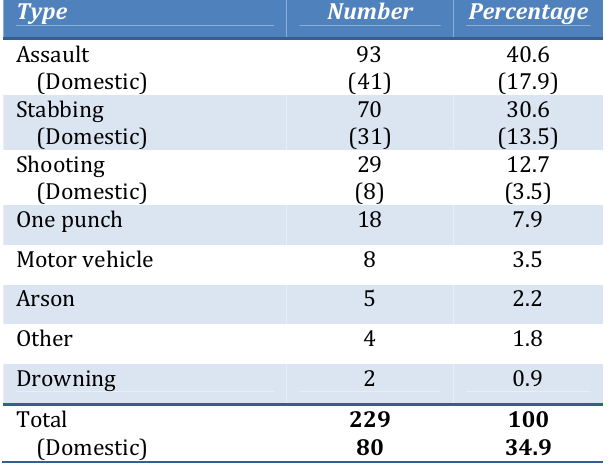
Table 2: Types of unlawful and dangerous act manslaughter cases in NSW, 1998 ‐